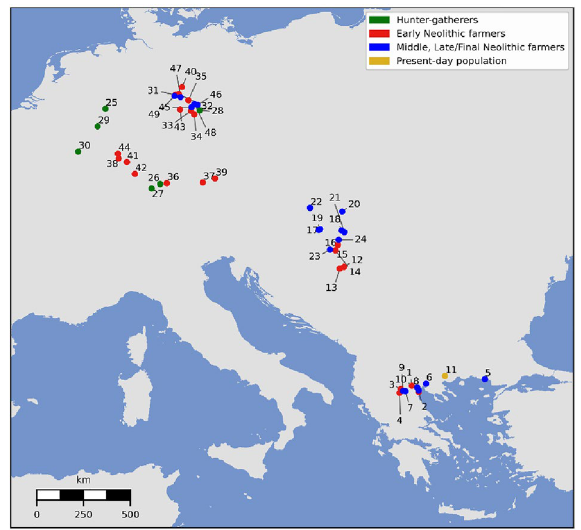
Figure 1. Geographical distribution of the mtDNA sequences (individual samples) used in the spatially explicit simulation framework. The coloured dots represent the geographical location of the mtDNA lineages from northern Greece (n = 45), central Europe (n = 200) and northern Balkans (n = 83). Hunter-gatherers (n = 19) are represented in green, Early Neolithic farmers (n = 177) in red, Middle and Late/Final Neolithic farmers (n = 132) in blue and present-day Greeks (n = 319) in yellow. Name (indicated in numbers) and precise chronology of the archaeological sites (locations) can be found in Table